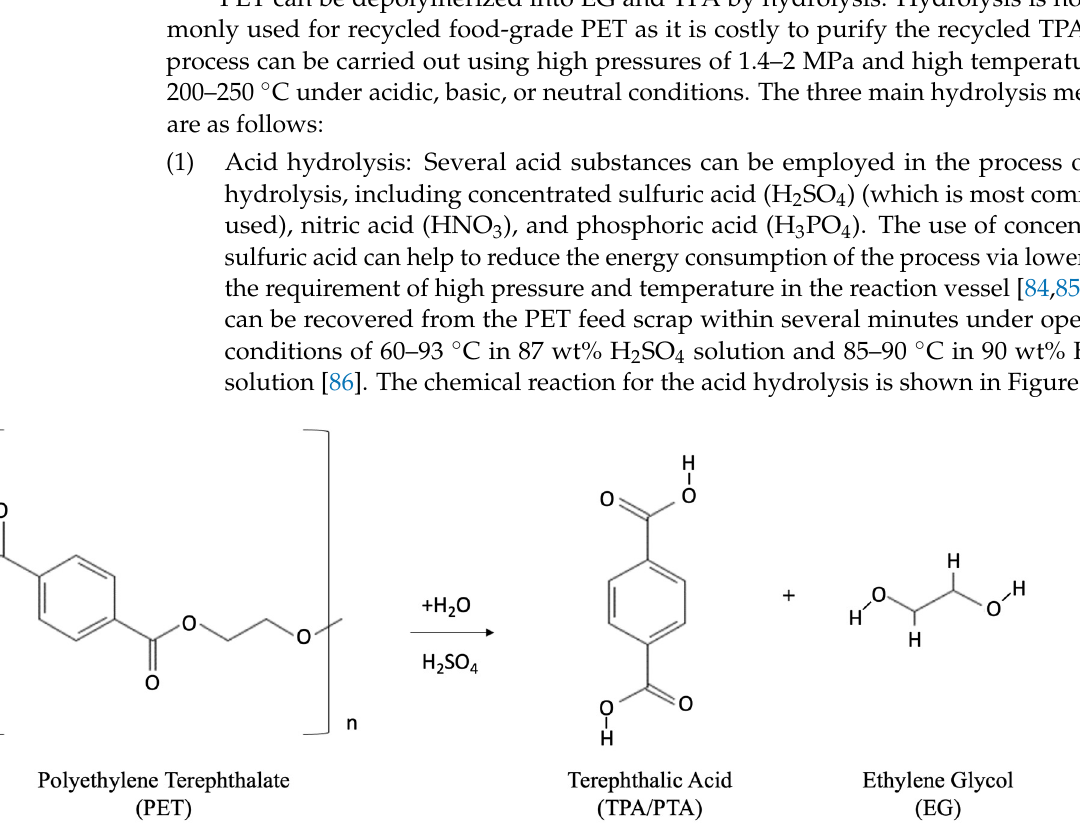
Figure 6. Chemical reaction for acid hydrolysis